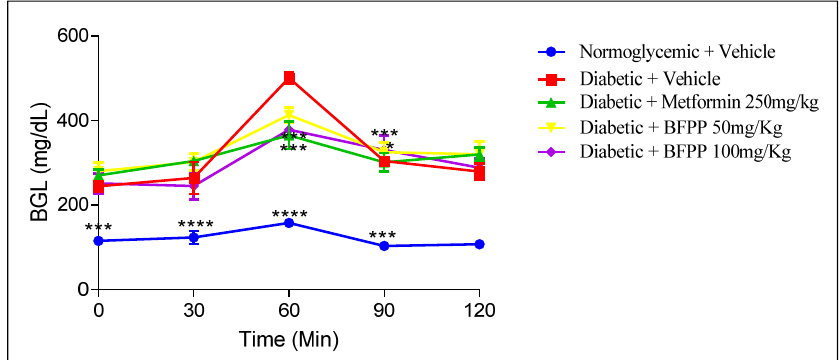
Figure 4. Hypoglycemic activity of BFPP on diabetic mice. Normoglycemic (blue), vehicle (red), metformin 250 mg/kg (green), BFPP 50 mg/Kg (yellow), BFPP 100 mg/Kg (purple). The data are expressed as mean ± SEM, n = 6 animals per group. Two-way ANOVA post-test Bonferroni; * p ≤ 0.05; *** p < 0.001 and **** p ≤ 0.0001 compared with the vehicle group.